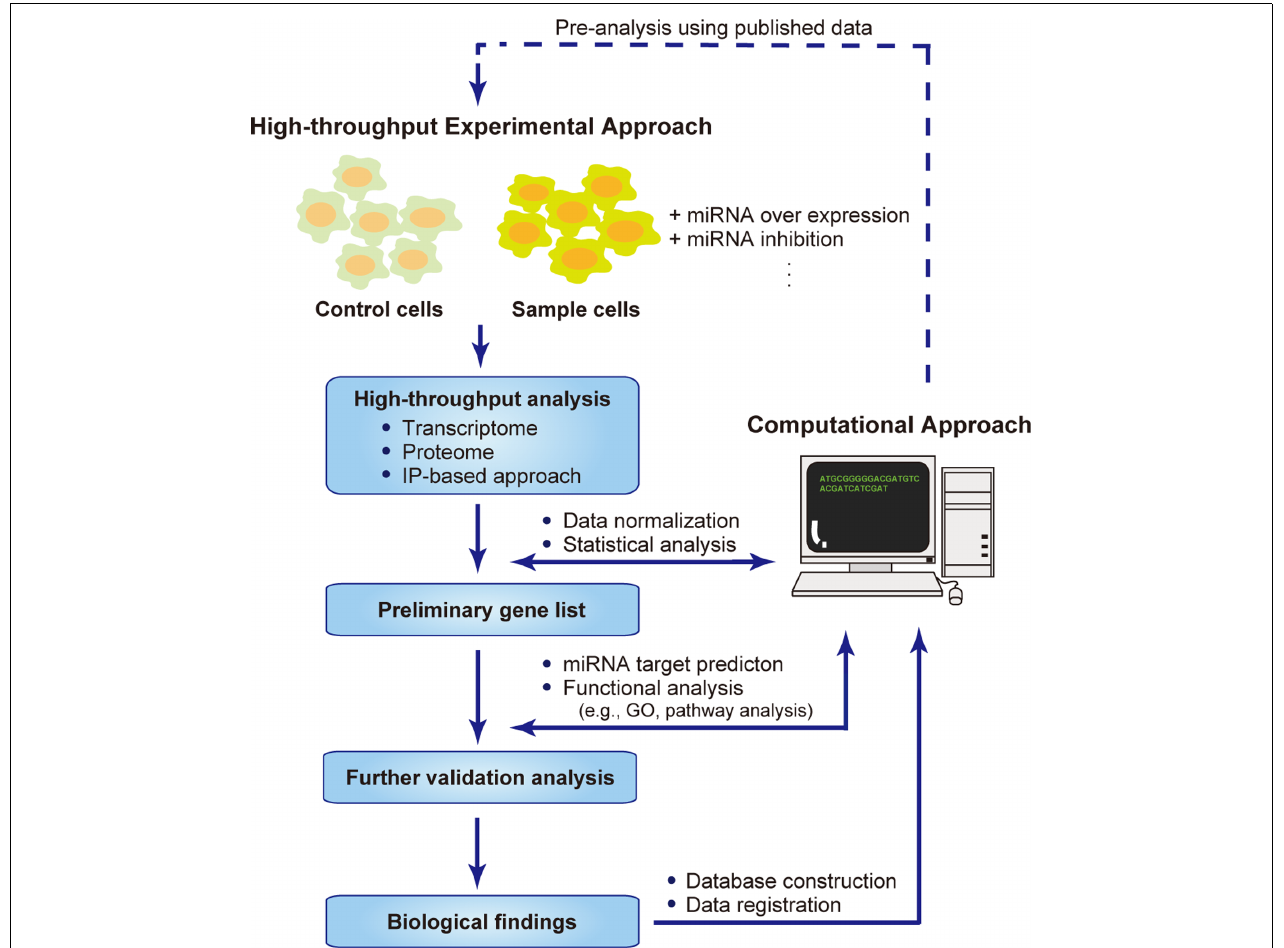
untreated population as the control.The data obtained are normalized and analyzed statistically to produce a preliminary list of genes with significantly up- or down-regulated expression. Further validation analysis is conducted to extract the biological information hidden behind the mass of data.The raw and analyzed data are distributed within databases or web services, allowing other researchers to make use of this